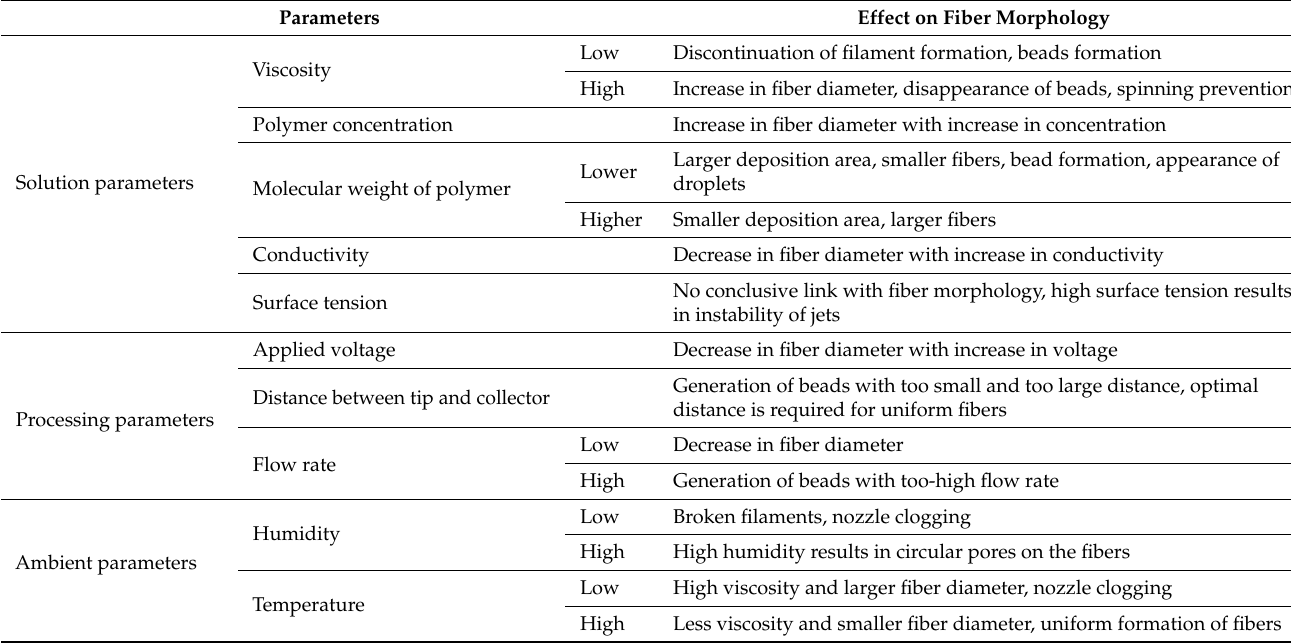
Figure 5. Influence of the process parameters on the fiber diameter obtained by the electrospin- ning method. Table 2. Electrospinning parameters (solution, processing, and environment) and their effect on fiber morphology.